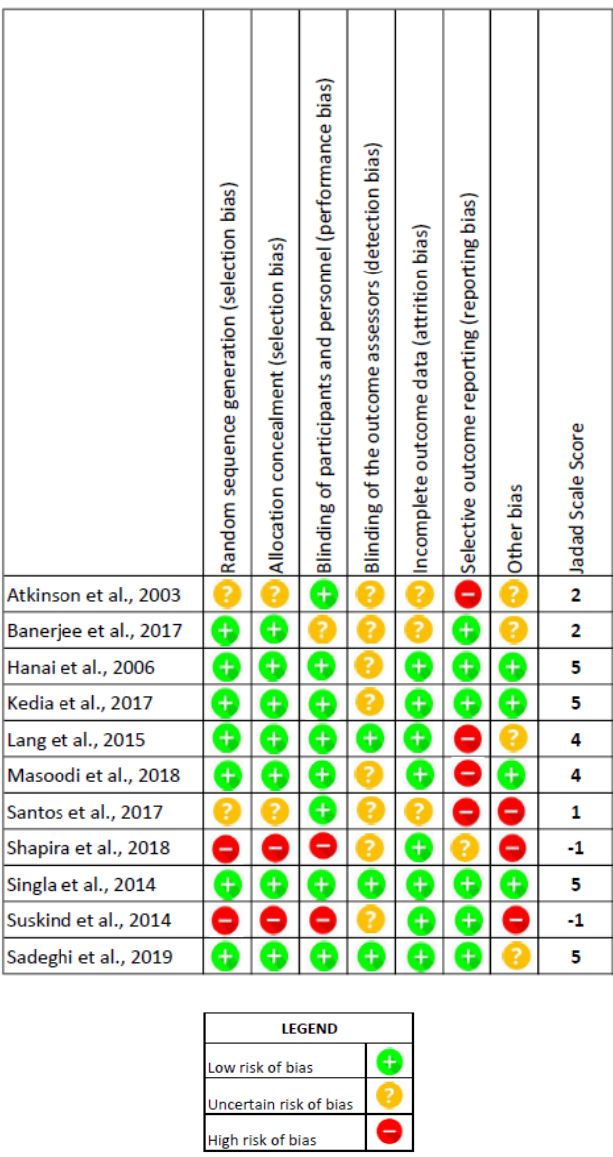
Figure 1. Flowchart of articles selected for the systematic review.